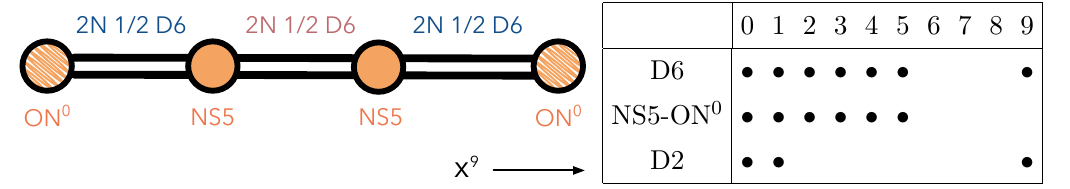
Figure 3. NS5-ON 0 -D6 brane system at n = 4.